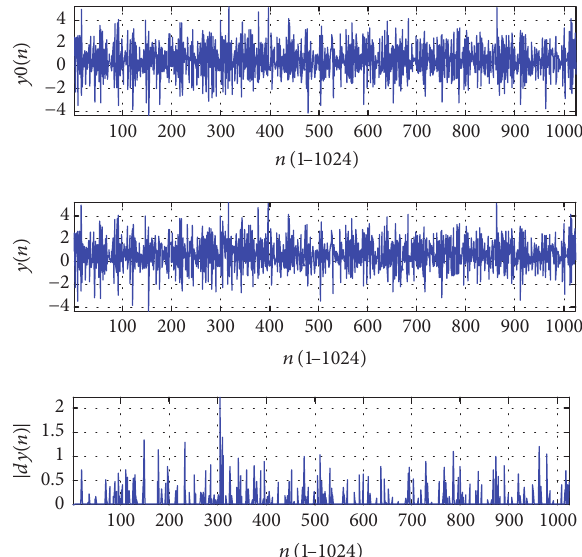
Figure 7: The comparison of the calculated output signals to the original observed